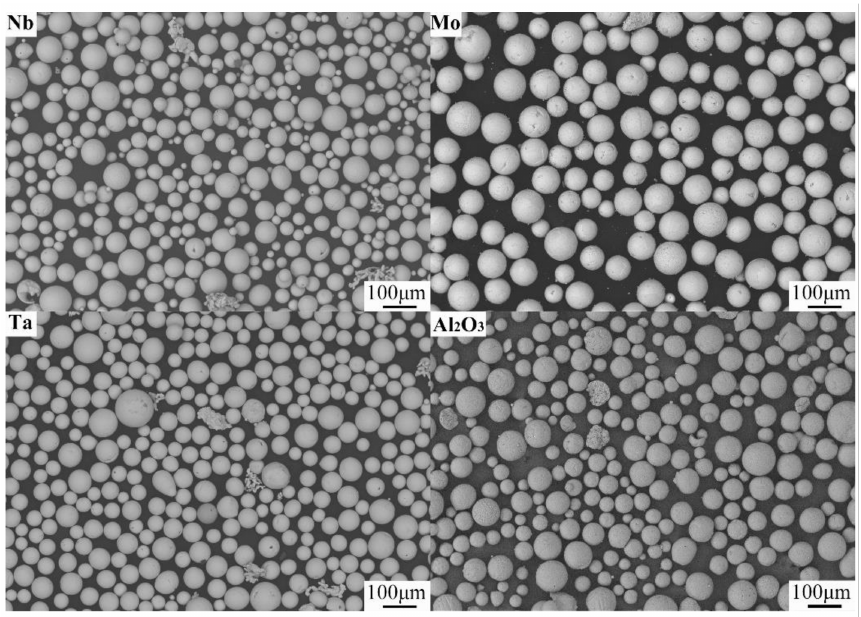
Figure 1. Nb, Mo, Ta, and Al 2 O 3 powders.